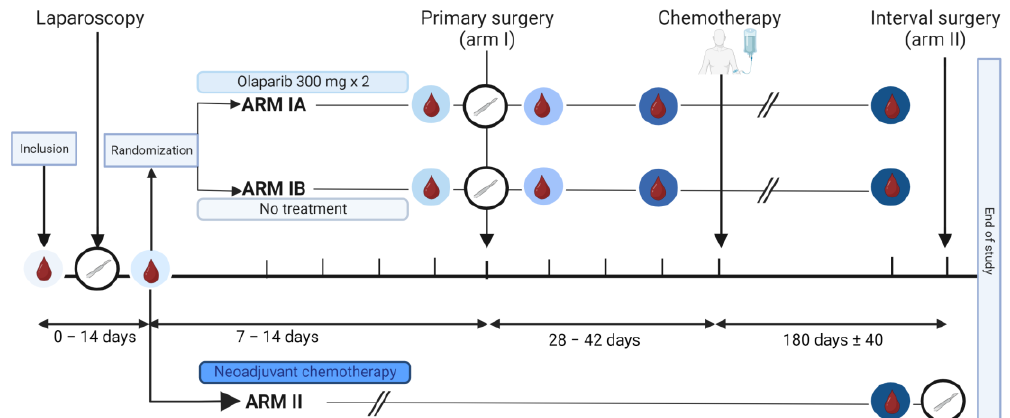
Figure 1. Graphical illustration of the IMPACT trial. The time points of the collection of serum samples are marked with blood drop symbols in circles with different shades of blue, and the time points of the surgeries are indicated by white circles containing a scalpel. Arm I included patients eligible for primary cytoreductive surgery (Predictive Index Value [PIV] score < 8). They were randomized into Arm IA or Arm IB. Patients in Arm IA, but not Arm IB, received an oral administration of olaparib tablets 300 mg × 2 for 7 – 14 days prior to the primary surgery. Patients in Arm II were laparoscopically evaluated to be inoperable (PIV ≥ 8) and received three rounds with neoadjuvant chemotherapy. Subgroups compared for serum analysis are shown in supplementary material (Figure S1). Created with BioRender.com